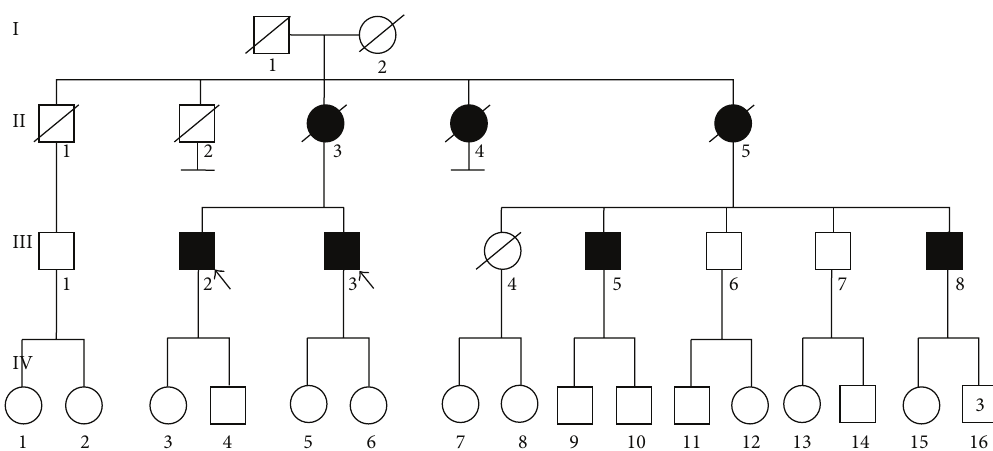
Figure 1: Family tree, black arrows indicate probands.